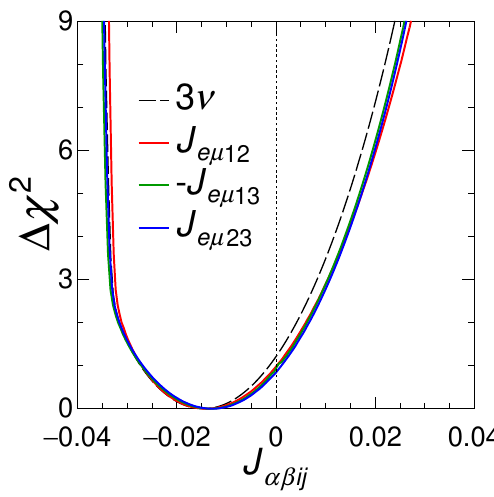
Figure 3 . 1-D ∆ χ 2 of the three Jarlskog factors associated to the ν e − ν µ sector: J eµ 12 ≡ = [ U e 1 U µ 2 U ∗ U ∗ ] (red), J eµ 23 ≡ = [ U e 2 U µ 3 U ∗ e 2 µ 1